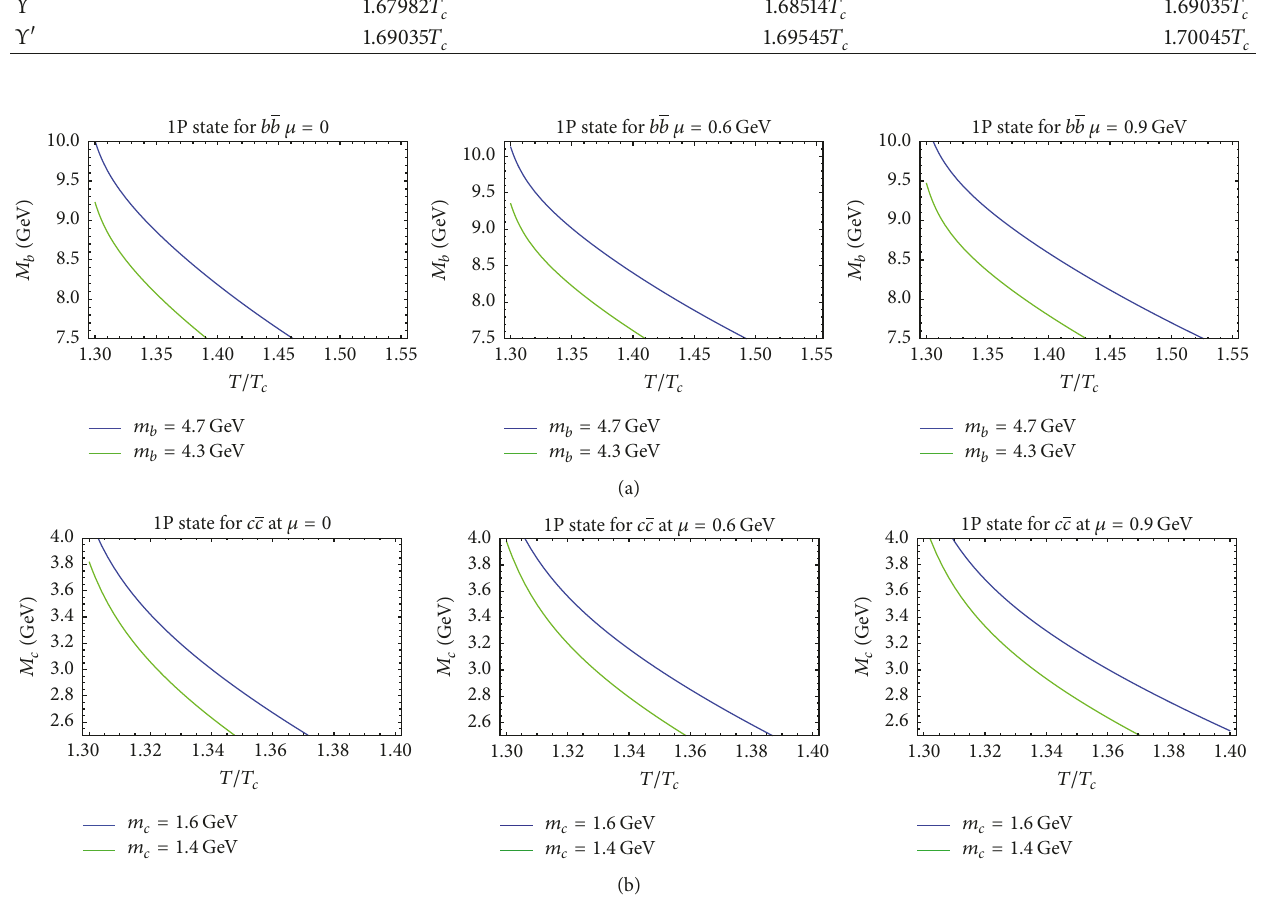
Figure 10: The mass spectra of heavy quarkonia are plotted as a function of temperature for 1P state, bottomonium in (a) and charmonium in